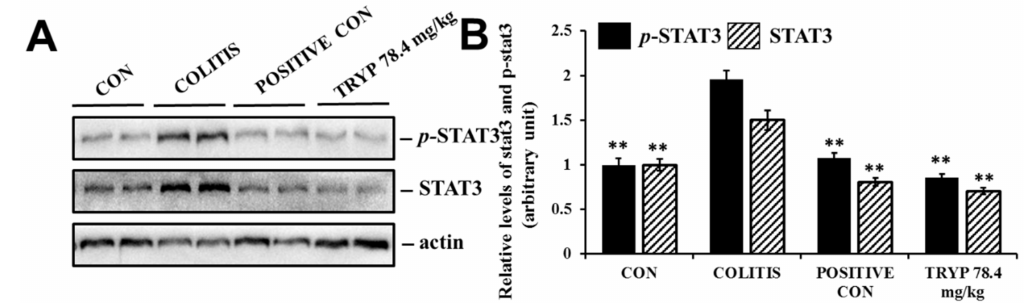
Figure 8. Effects of TRYP on the protein levels of STAT3 and p -STAT3. ( A ) Results of TRYP with concentration of 78.4 mg/kg on the protein level of stat and p -STAT3; ( B ) The column charts represented the relative protein level of stat and p -STAT3. Error bars represented means ± SEM of n = 3, ** p < 0.01 compared with